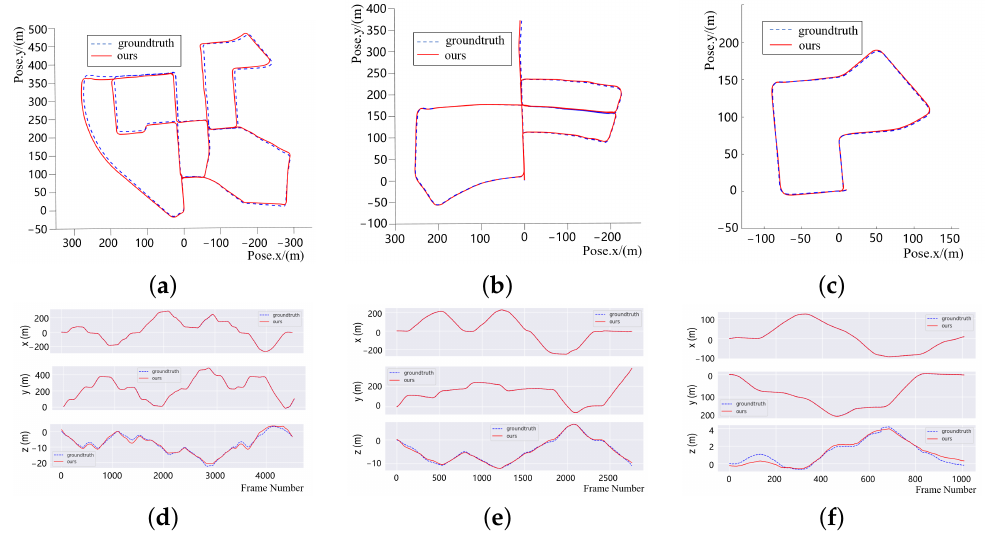
Figure 8. The experimental results on KITTI. The trajectory output of our proposed approach is plotted as a red solid line, while the ground truth is plotted as a blue dashed line. ( a ) KITTI00 trajectory; ( b ) KITTI05 trajectory; ( c ) KITTI07 trajectory; ( d ) KITTI00 error distribution; ( e ) KITTI05 error distribution; and ( f ) KITTI07 error